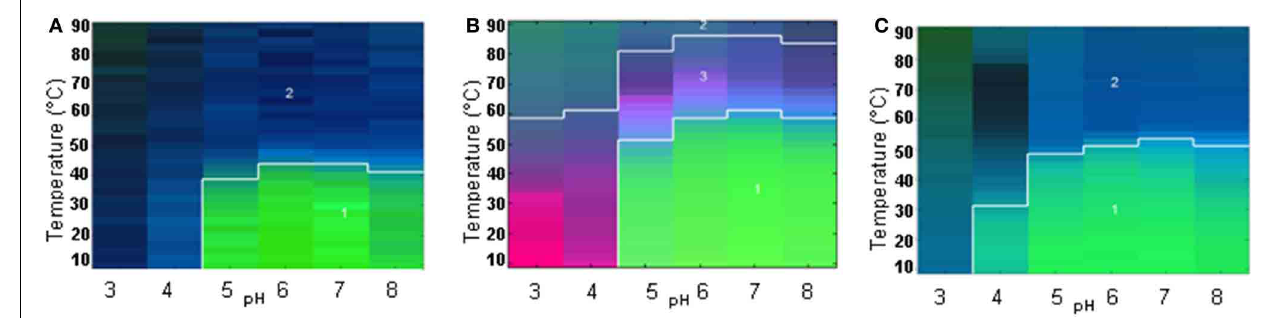
FIGURE 3 | Empirical Phase Diagrams (EPDs) for comparative analysis of conformational stability of FGF-1 and its mutant. The EPDs were developed for wildtype FGF-1 (A) , wildtype FGF-1 with heparin (B) and K12V/C117V/P134V mutant of FGF-1 (no heparin) (C) . Stability data as function